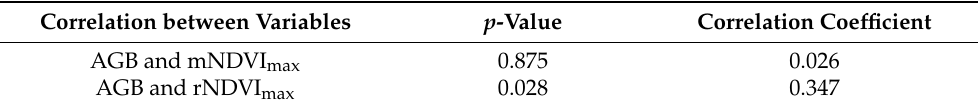
Table 2. Correlation results between AGB, modelled maximal NDVI (mNDVI max ), and maximal NDVI values (rNDVI max ). Spearman’s correlation test was used. Correlation between Variables p -Value Correlation Coefficient AGB and mNDVI max 0.875 0.026 AGB and rNDVI max 0.028 0.347